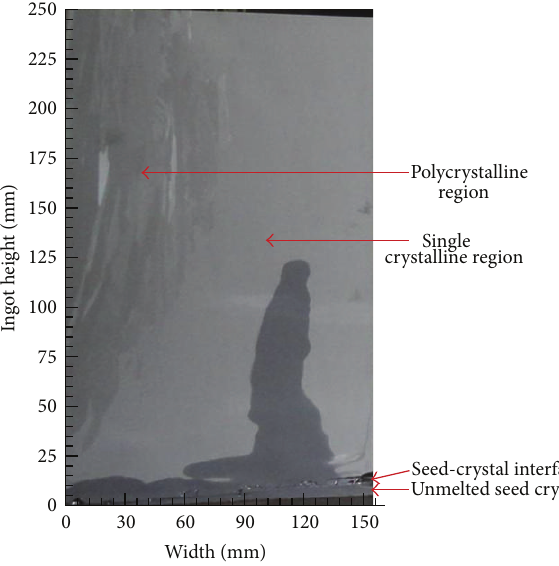
Figure 9: Preservation of seed crystals in the